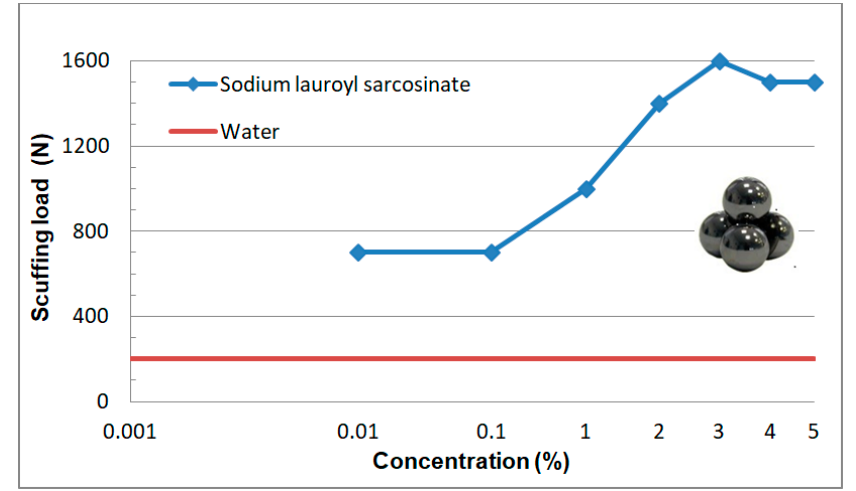
Figure 10. Dependence of scuffing load (P t ) on concentration of sodium lauroyl sarcosinate (SLS) in aqueous solution. Solid line describes P t value for water (200 N). T02 tester, load increase velocity 409 m/s, spindle speed 500 rpm.